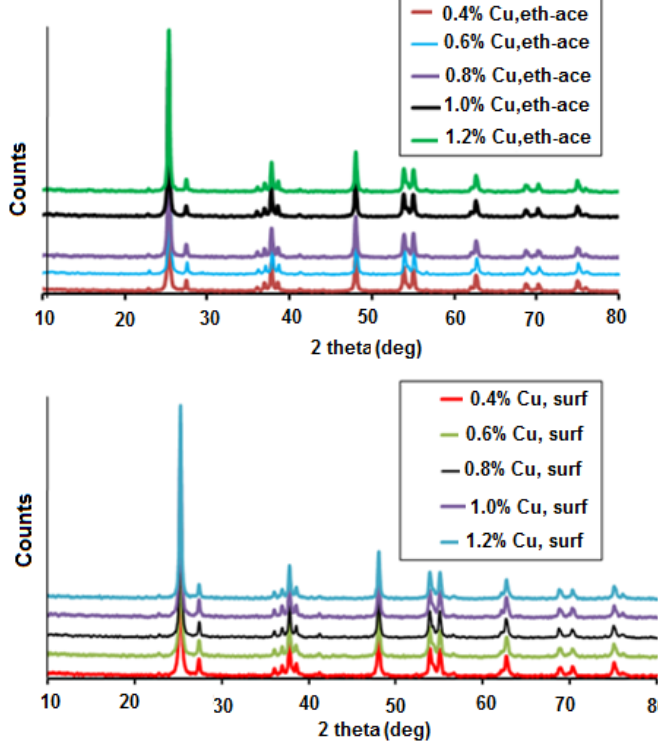
Fig. 1. The XRD patterns of the Cu/TiO samples prepared in two different 2 Fig. 1 The XRD patterns of the Cu/TiO 2 samples prepared in two different media